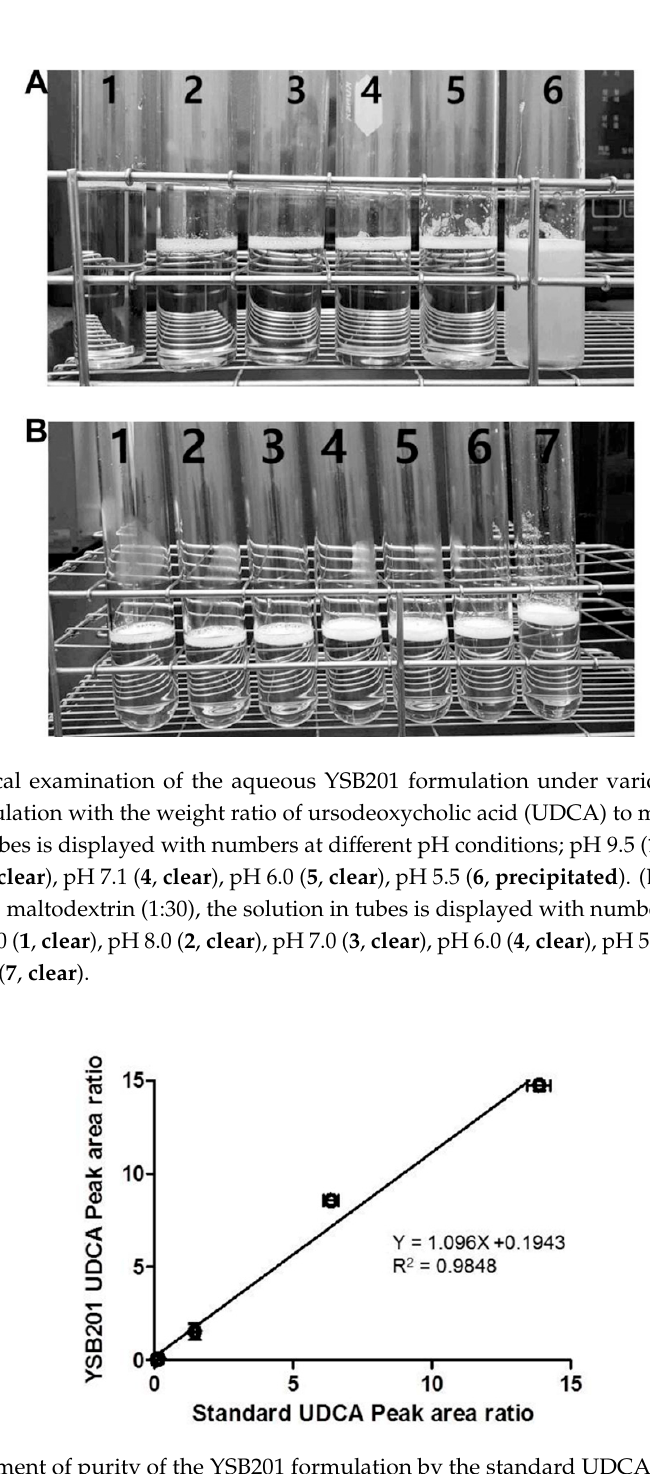
Figure 5. Assessment of purity of the YSB201 formulation by the standard UDCA. The UDCA peak area ratios compared with IS peak area in the diluted YSB201 agent were compared with the UDCA peak area ratio values of the standard UDCA.